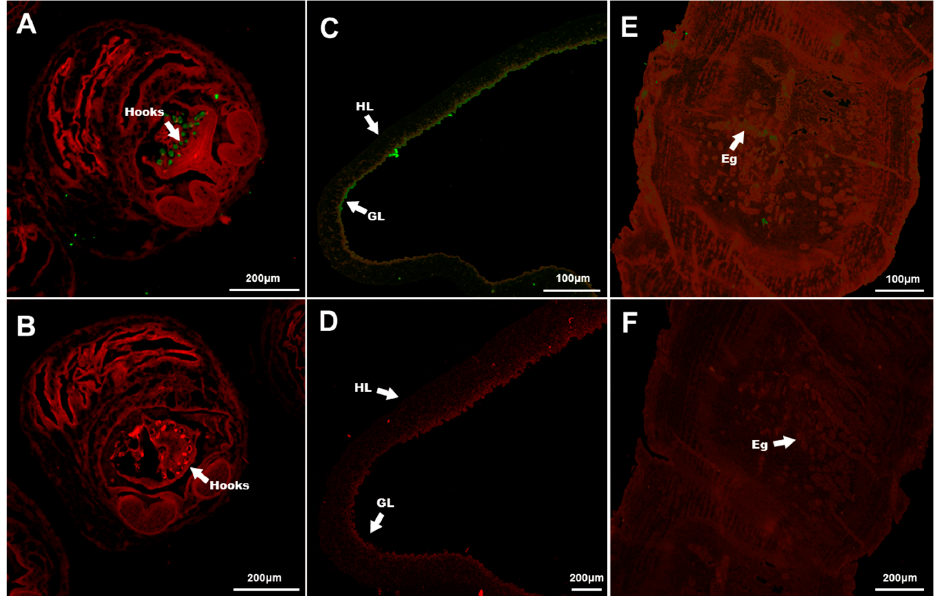
Figure 6. Immunofluorescence localization of TmAnxB2 in T. multiceps . Against the red background, the green fluorescent color shows the location of the native TmAnxB2 protein: ( A ) protoscolex with positive serum; ( B ) protoscolex with negative serum; ( C ) cyst wall with positive serum; ( D ) cyst wall with negative serum; ( E ) gravid proglottids with positive serum; and ( F ) gravid proglottids with negative serum; GL, germinal layer; HL, horny layer; Eg, eggs.